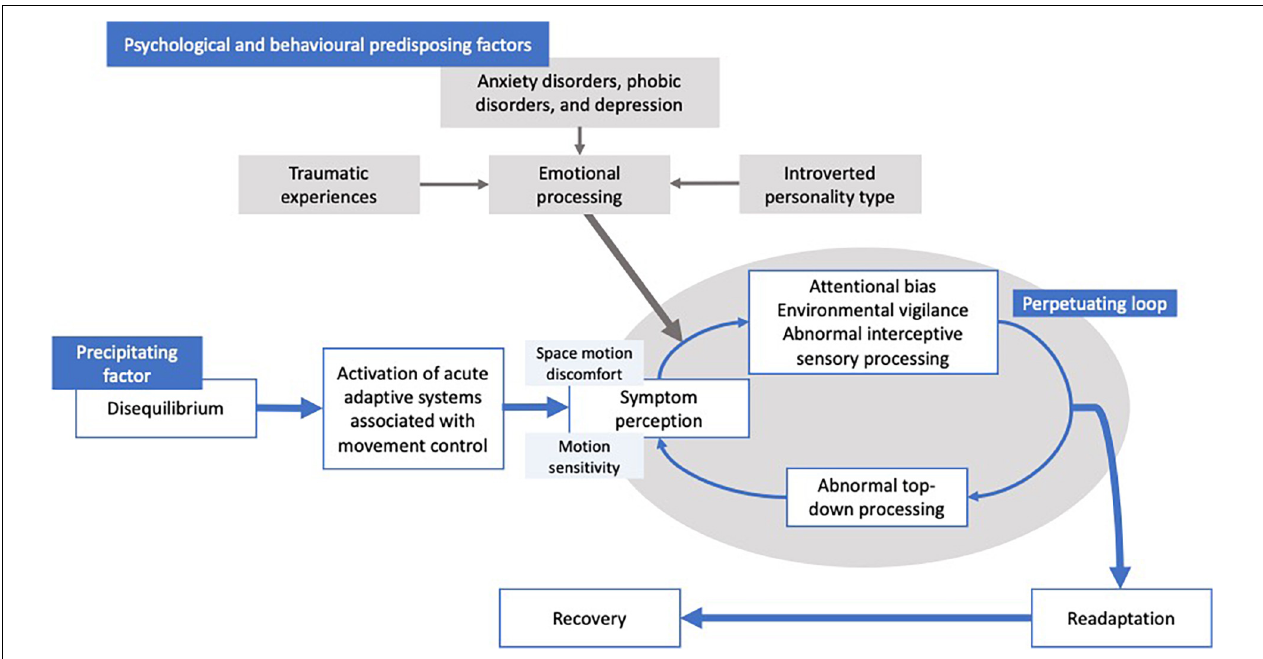
FIGURE 1 | Graphical depiction of the mechanisms suggested to be involved in functional dizziness. That is, a participating factor (i.e., vestibular loss, medical cause, and anxiety) causes disequilibrium, leading to a transient distortion of vestibular perception impairing cognitive control of movement and balance. Psychological factors and behavioral co-morbidities (i.e., anxiety, phobia, emotional trauma, and personality types) are suggested to increase the likelihood of the transient perceptual distortions to persist, resulting in a perpetuating loop causing a failure of